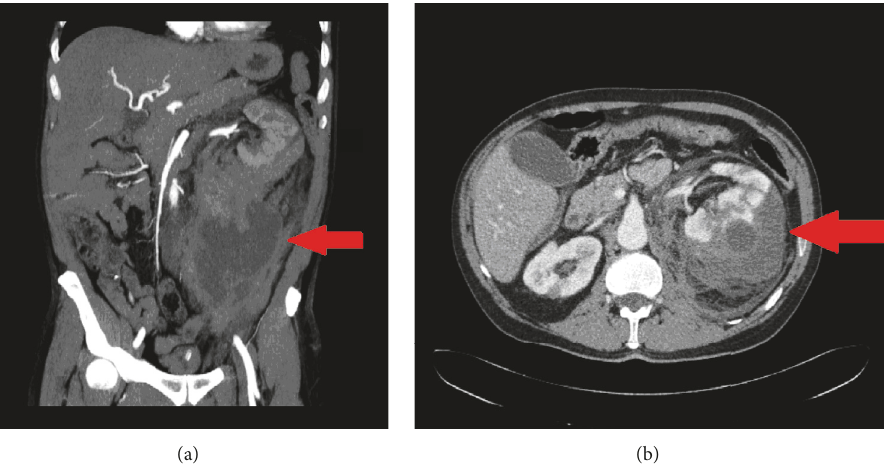
Figure 1: A coronary and a horizontal view of an abdominal CT with intravenous contrast that revealed a 17x11x8cm 3 spontaneous retroperitoneal hematoma (shown with arrow) due to bleeding of an intraparenchymal branch of the left renal artery extending from the left kidney down to the pelvis are shown ((a) and (b),